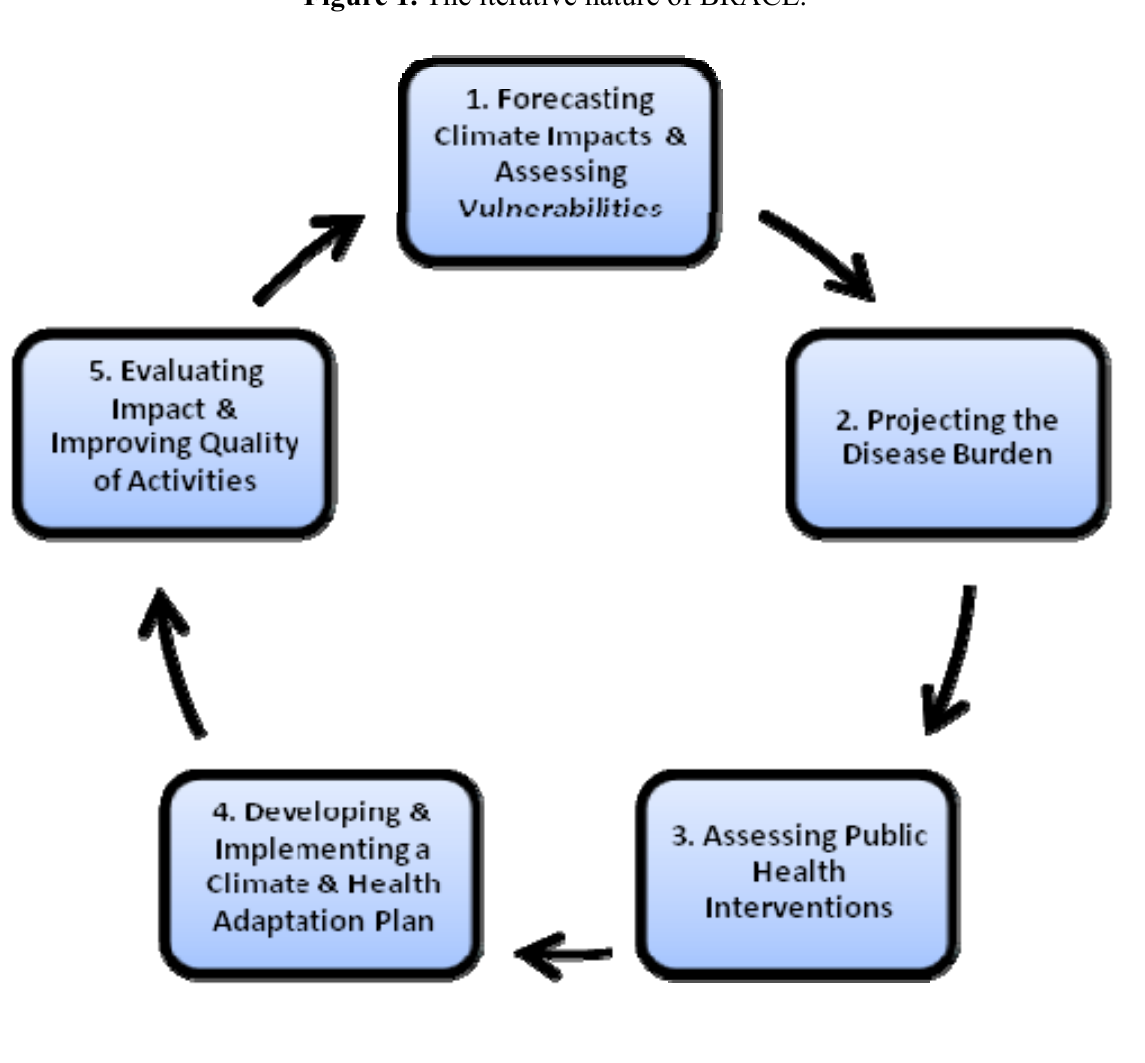
Figure 1. The iterative nature of